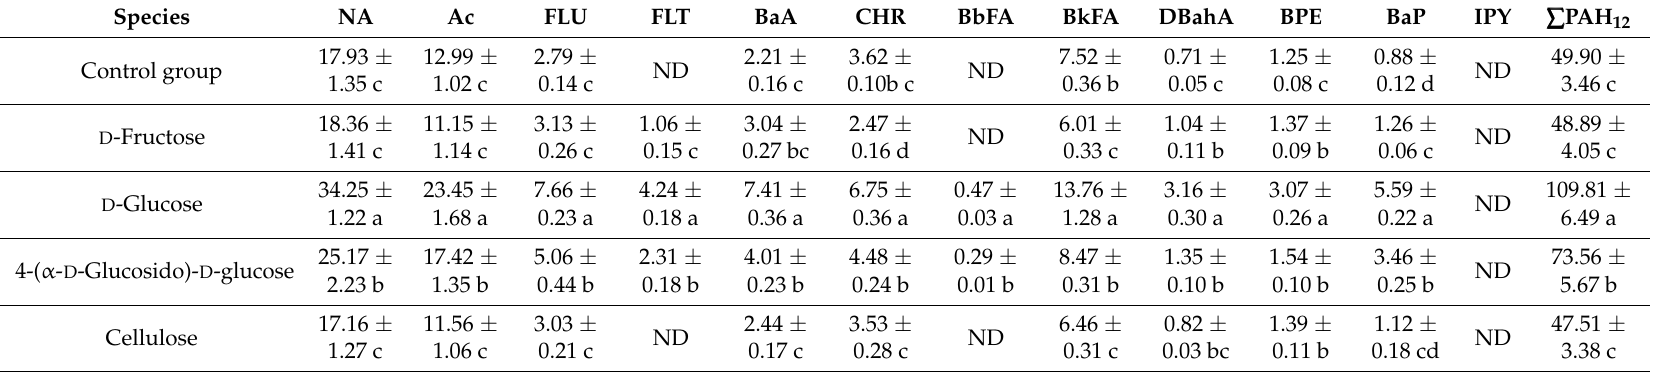
Table 2. Concentrations ( n = 3) of 12 PAHs produced as a consequence of adding different carbohydrates to grilled sausages.